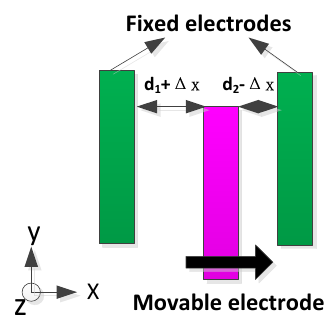
Figure 2. The stiffness match electrodes.